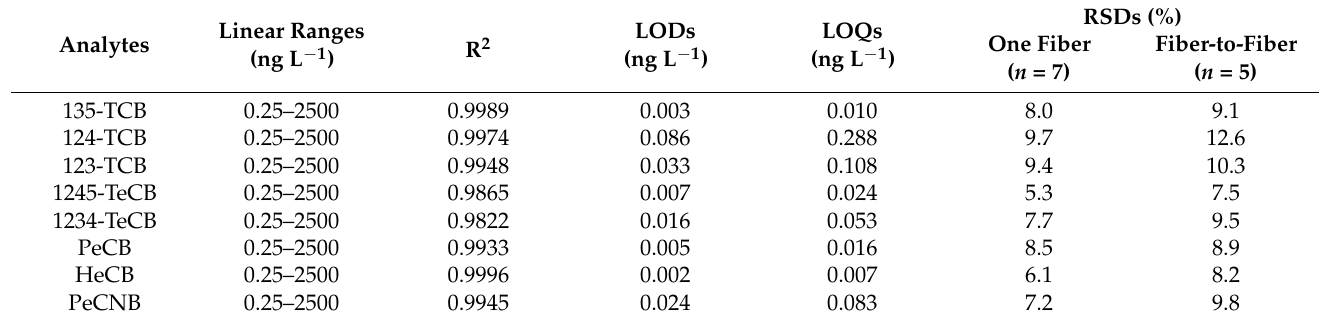
Table 1. Analytical performance of the CDs/g-C 3 N 4 SPME coating towards CBs.